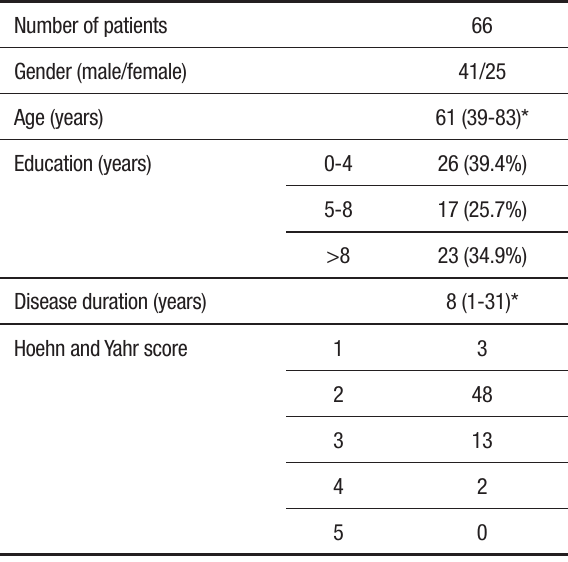
Table 1. Demographic and clinical features of the sample of patients with